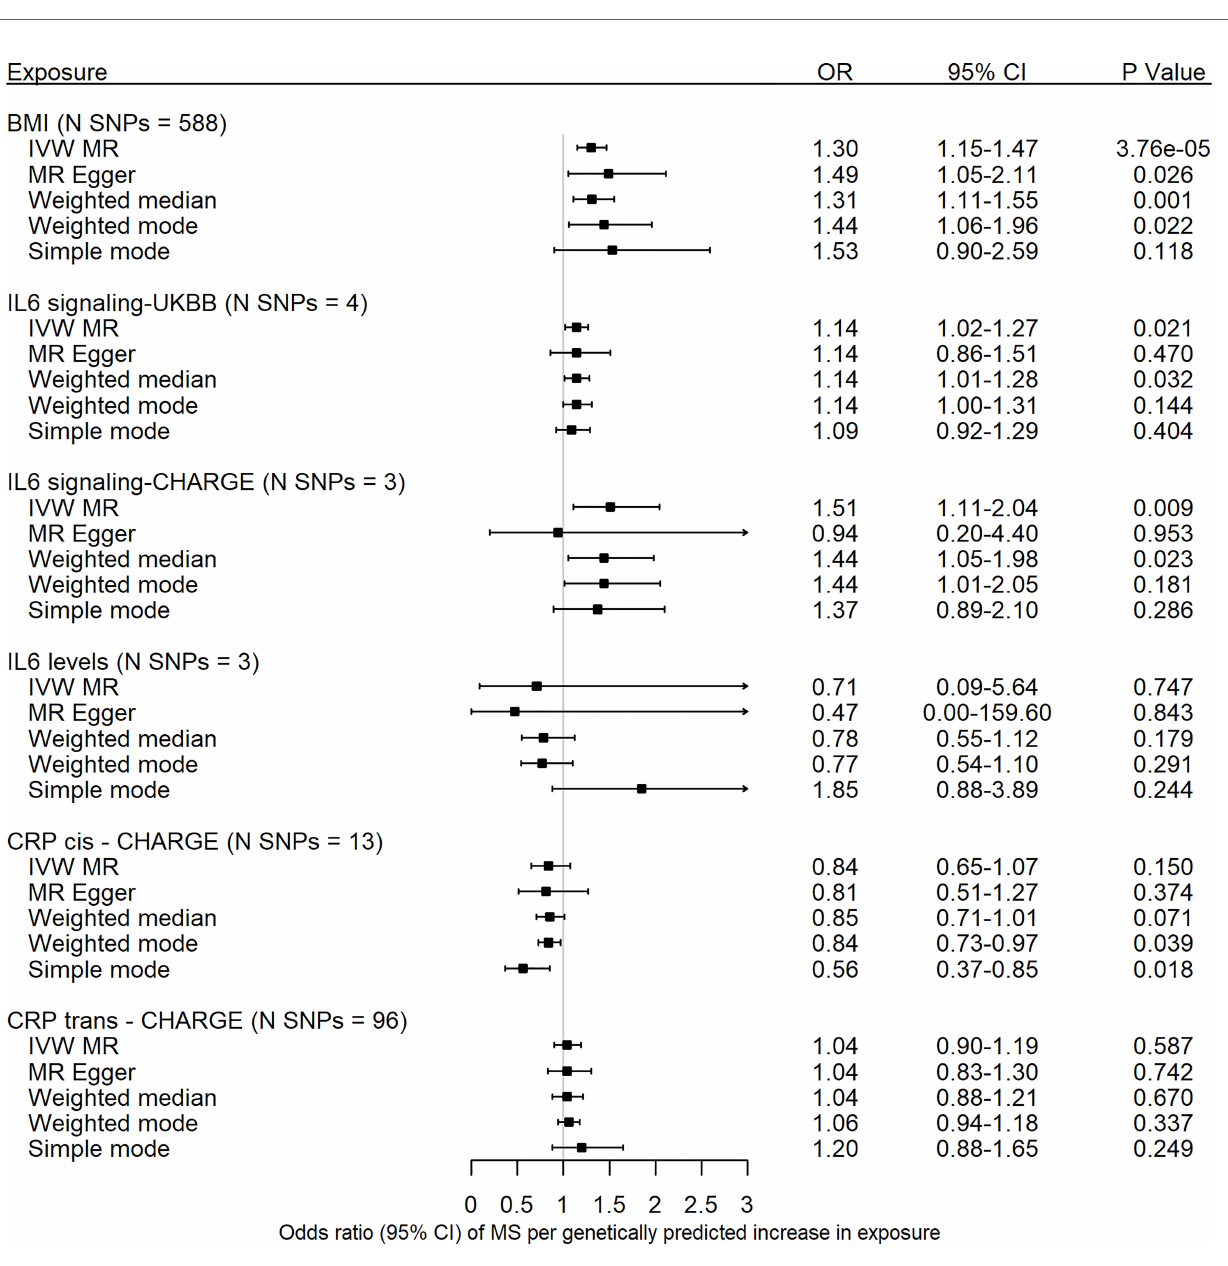
FIGURE 2 | Forest plot of univariable Mendelian randomization estimates of body mass index, interleukin-6 signaling, interleukin-6 levels and c-reactive protein with risk of multiple sclerosis. Data are displayed as odds ratio (OR) and 95% con fi dence interval (CI) per SD increase in genetically predicted BMI levels, per unit increase in c-reactive protein (CRP) levels for interleukin-6 (IL-6) signaling UKBB, per unit increase in natural-log transformed CRP levels for IL-6 signaling CHARGE and CRP CHARGE, and per unit increase in natural-log transformed IL-6 levels for IL-6 levels CHARGE. UKBB, UK Biobank; CHARGE, Cohorts for Heart and Aging Research in Genomic Epidemiology; CRP, c-reactive protein; MR, Mendelian randomization; N SNPs, number of variants in the analysis; SNP, single nucleotide polymorphisms; IVW, inverse-variance weighted